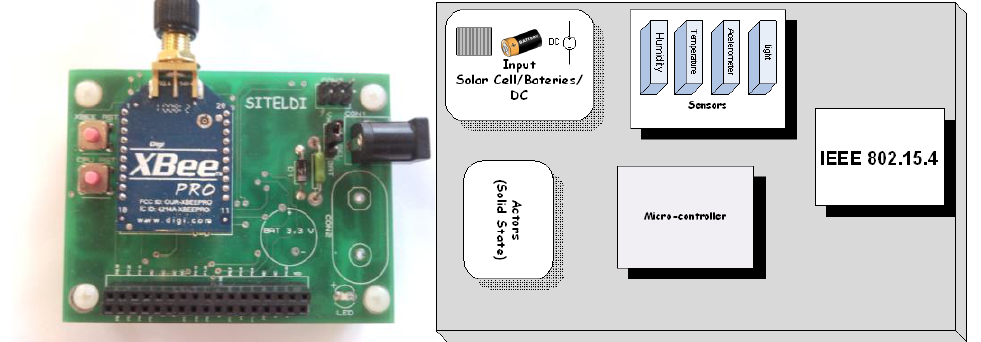
Figure 1. Picture and the block diagram of the wireless sensor